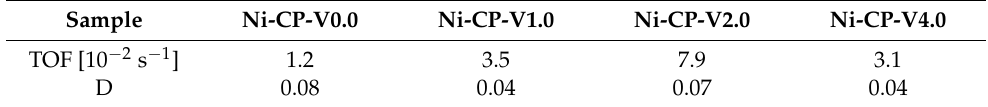
Table 1. Turnover frequency and dispersion for hydrotalcite-derived